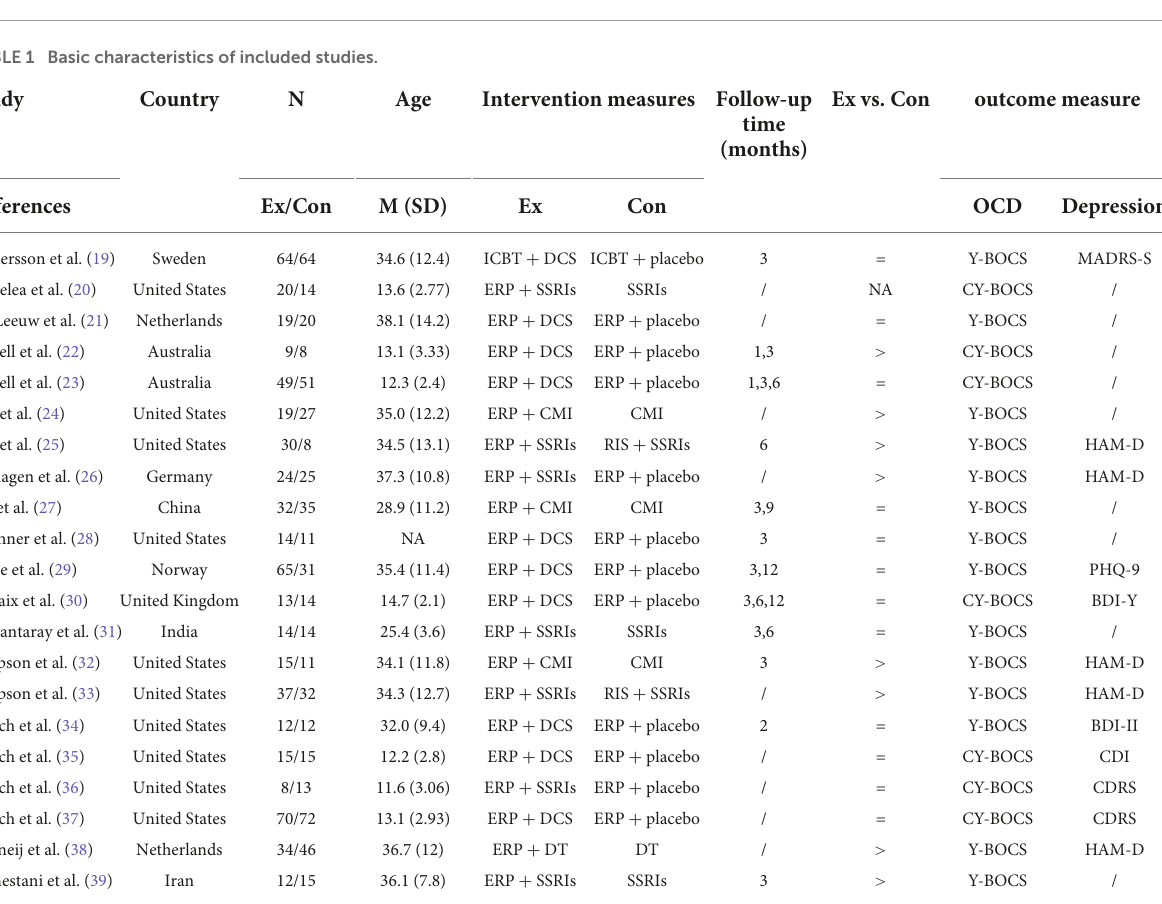
FIGURE2 Risk of bias summary.